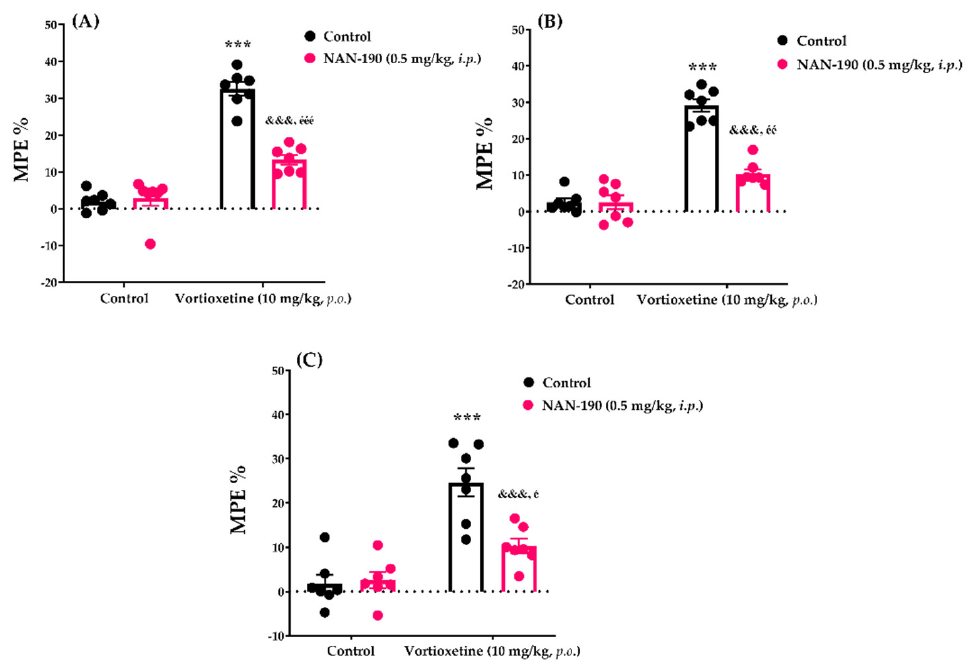
Figure 6. Involvement of serotonergic 5HT 1A receptors in the antinociceptive effects of vortiox-etine in the tail-clip ( A ), tail-immersion ( B ) and hot-plate ( C ) tests. Significant difference against vehicle treated control groups *** p < 0.001; Significant difference against vortioxetine administrated control groups &&& p < 0.001; Significant difference against NAN-190 administrated control groups é p < 0.05, éé p < 0.01, ééé p < 0.001. Two-way ANOVA, post-hoc Bonferroni test, n = 7.